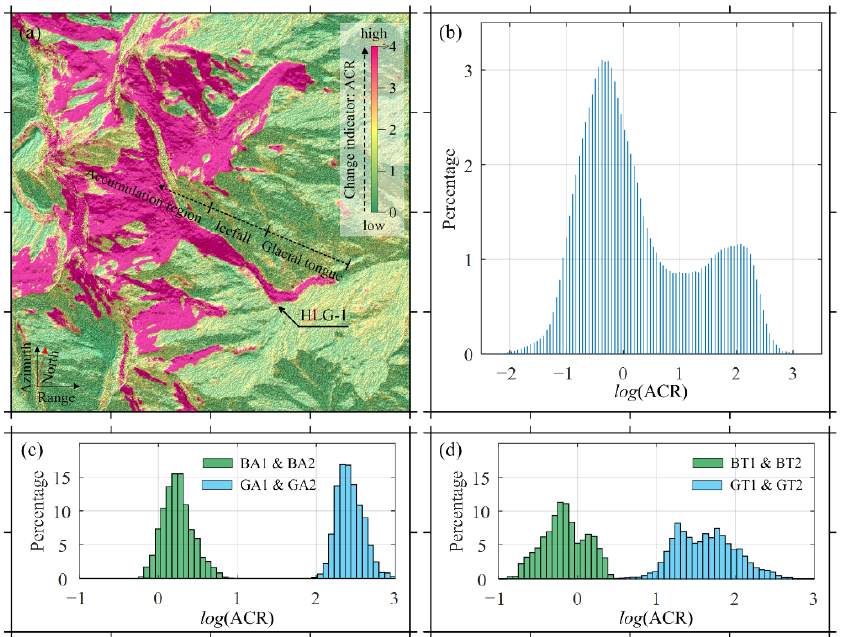
Figure 5. ( a ) ACR map in the SAR image coordinates; ( b ) the histogram of ( a ) after logarithmic transformation; ( c , d ) the log-transformed ACR value histograms for the samples from the accumulation region and glacial tongue region, respectively.